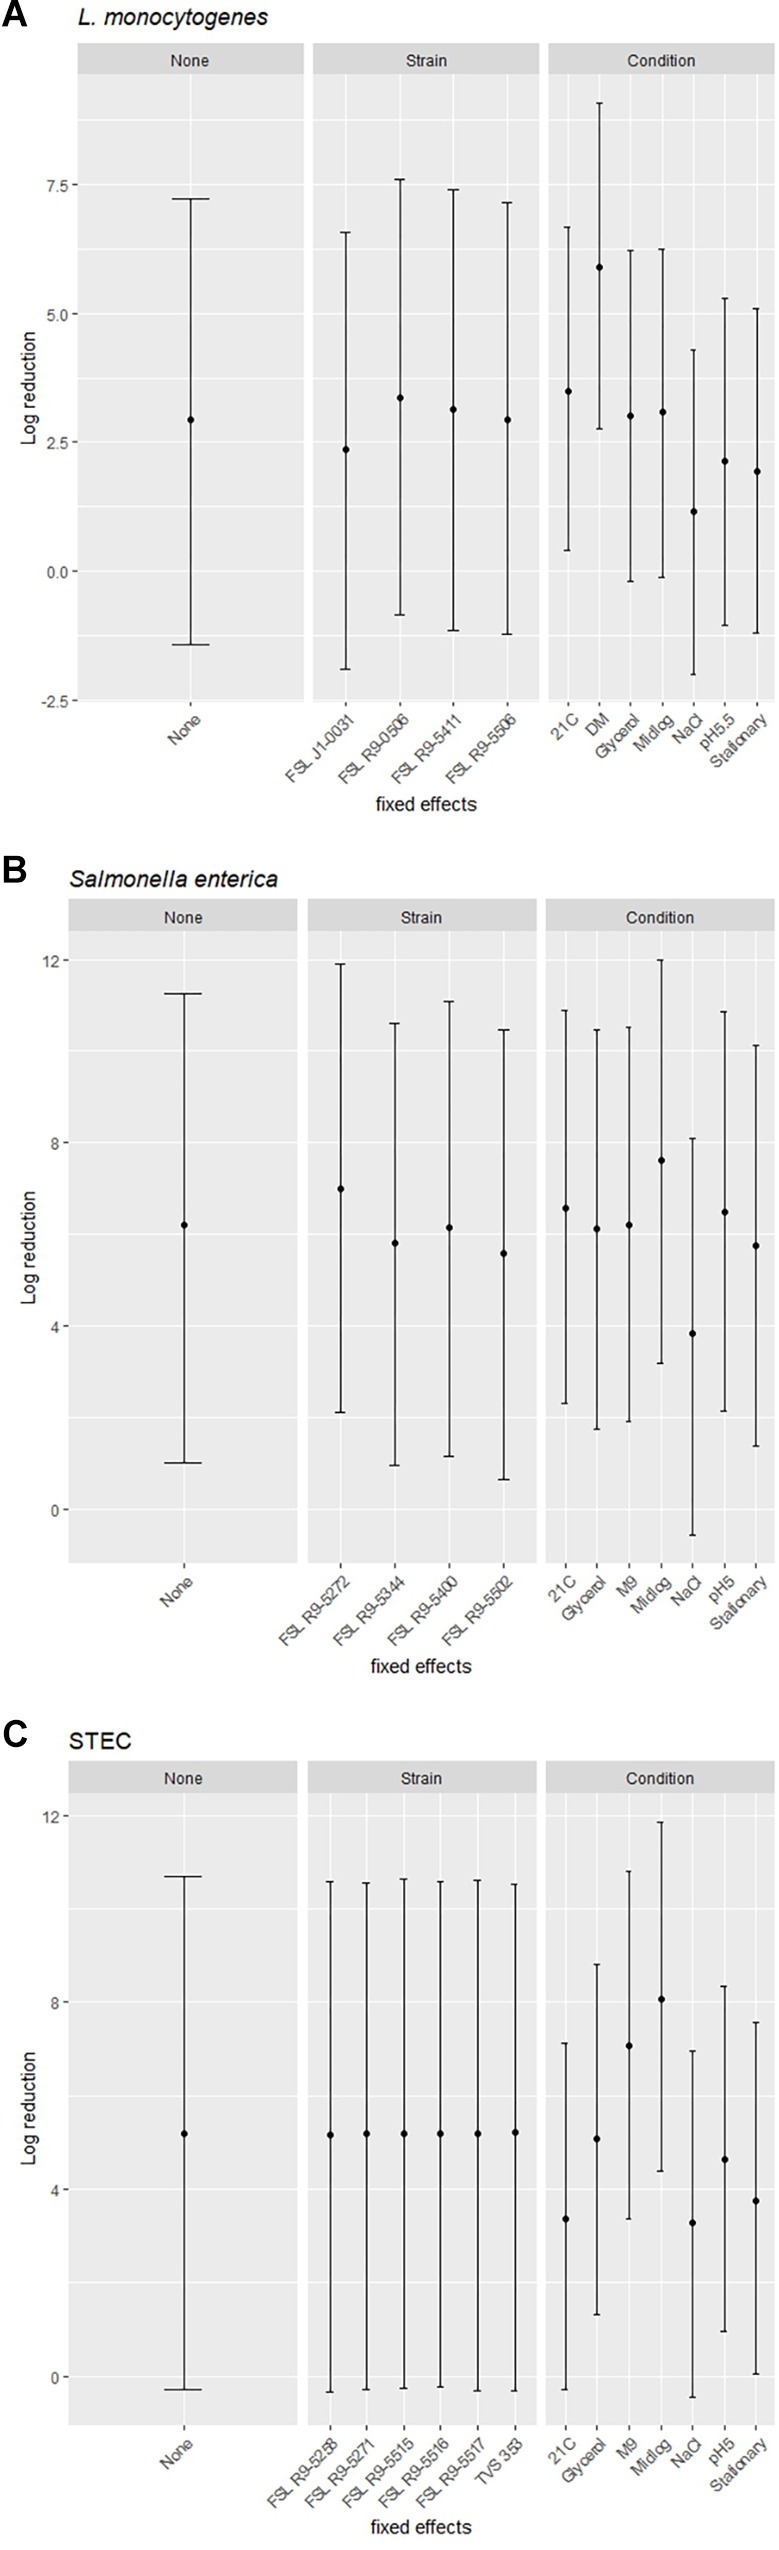
Estimated ranges of log reduction after PAA exposure for different combinations of strains and pre-growth conditions. 95% prediction intervals for log reduction were estimated based on a crossed-random effects model where no effect was fixed (left panel, labeled “None”), the effect of strain was fixed, and conditions were random effects (middle panel, labeled “Strain”), and the effect of condition was fixed and strains were random effects (right panel, labeled “Condition”). The error bars of the 95% prediction intervals show the range of responses in log reduction (y-axis) for a given effect after exposure to PAA of (A)
L. monocytogenes, (B)
S. enterica, and (C) STEC.